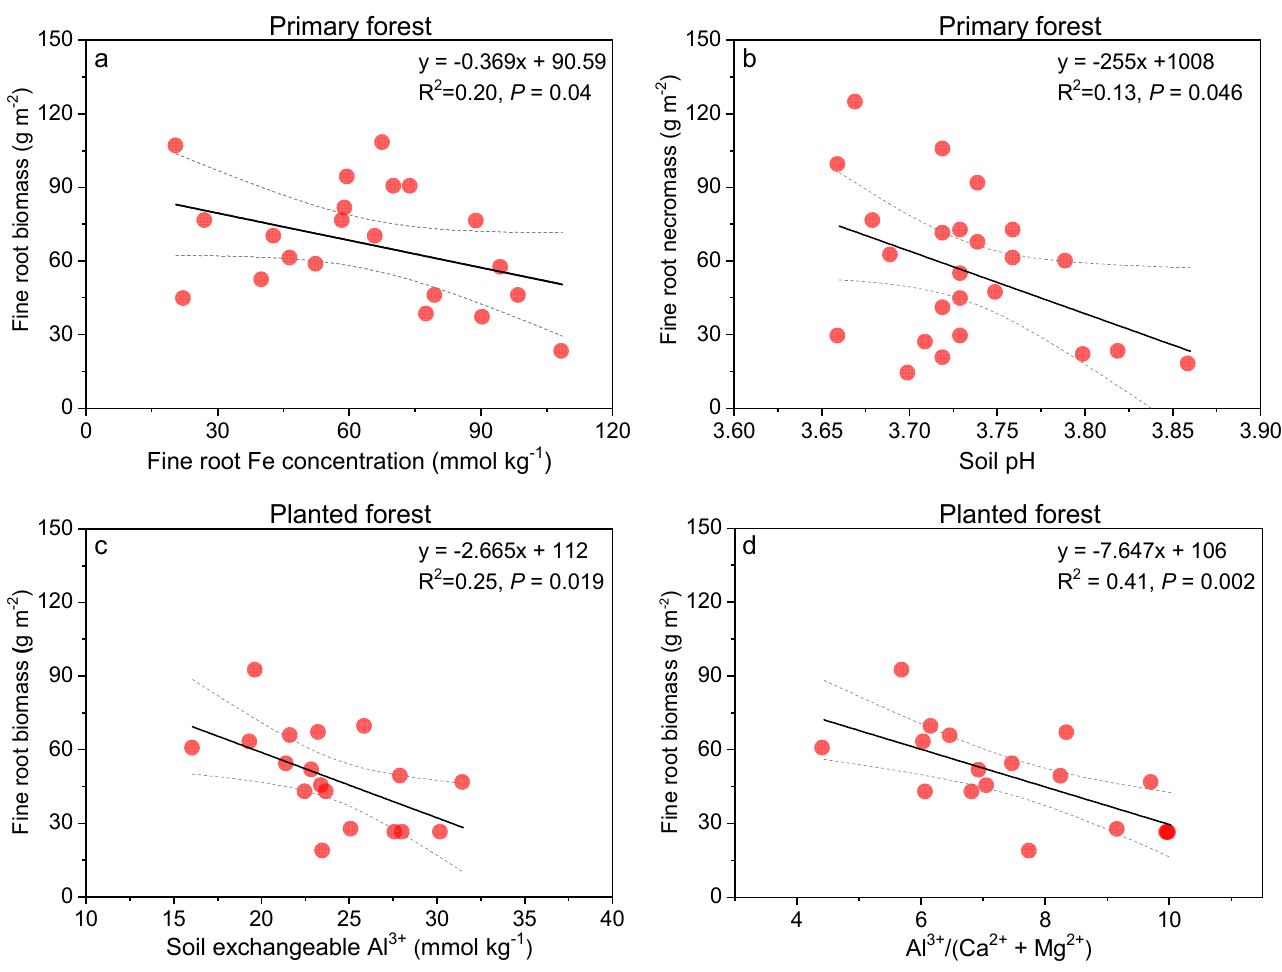
Figure 7. Relationships between fine root Fe concentration (mmol kg − 1 ) and fine root biomass (g m − 2 , a ), soil pH and fine root necromass (g m − 2 , b ) in the primary forest, and between soil exchangeable Al 3+ (mmol kg − 1 , c ), Ca:Al ratio ( d ), and fine root biomass (g m − 2 ) in the planted forest in southern China after 8 years of N treatment.